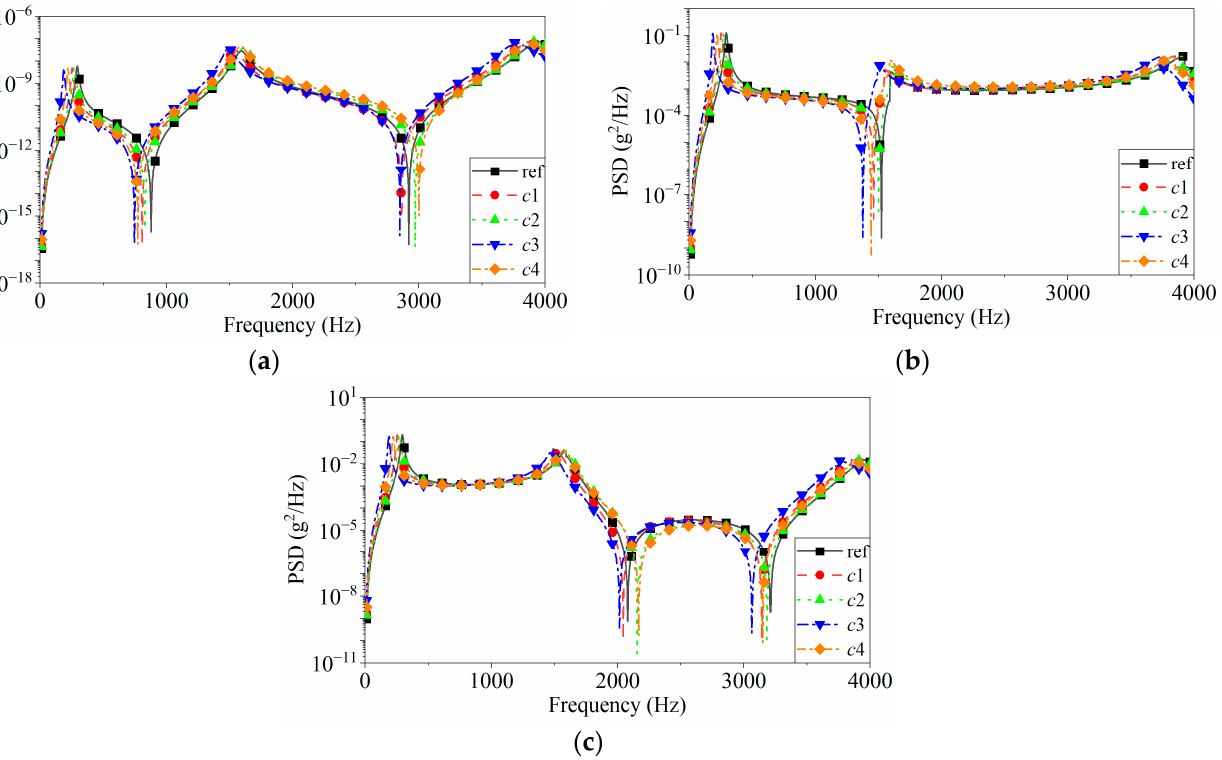
Figure 14. PSD curves of acceleration in the z-direction under different combined loads at various locations: ( a ) PSD curves for point located at x = 150 mm ( b ) PSD curves for point located at x = 100 mm; ( c ) PSD curves for point located at x = 75 mm.